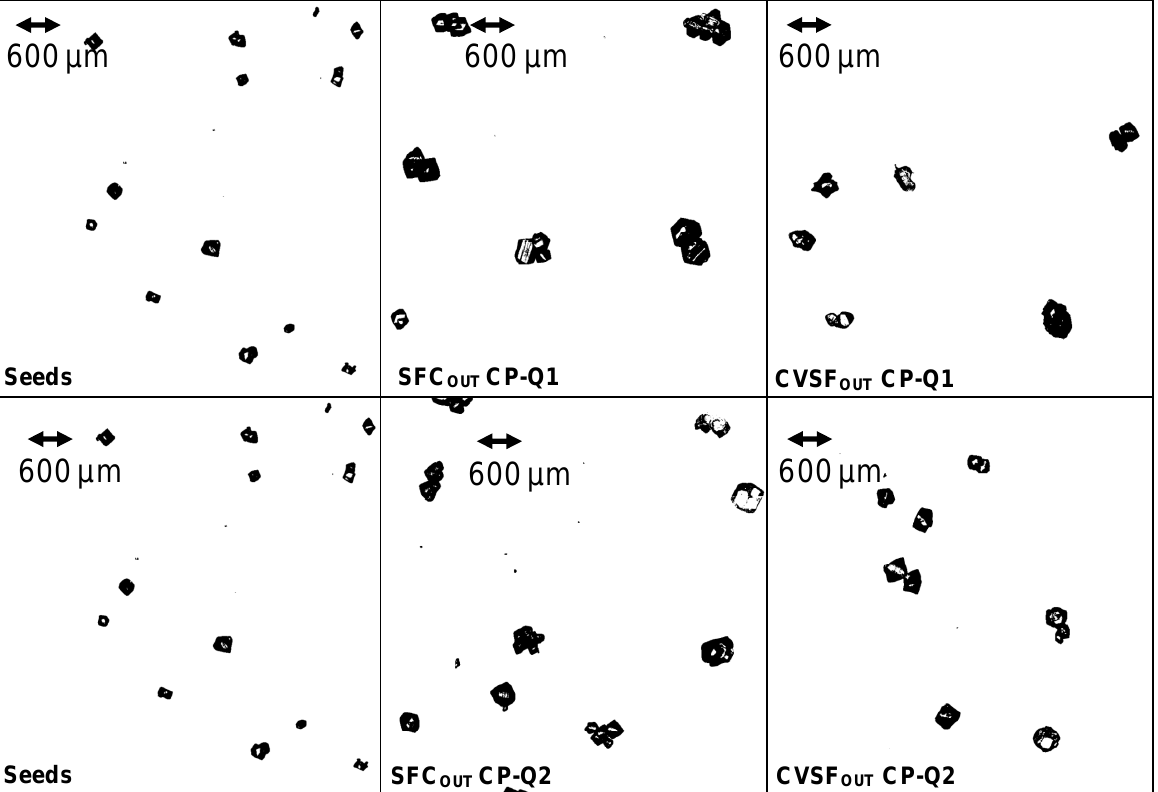
Figure 8. Exemplary QICPIC binary images, ( upper half ) experiment CP-Q1 and ( lower half ) experiment CP-Q2. ( Left ) Seeds, ( middle ) after the SFC, and ( right ) after the CVSF.